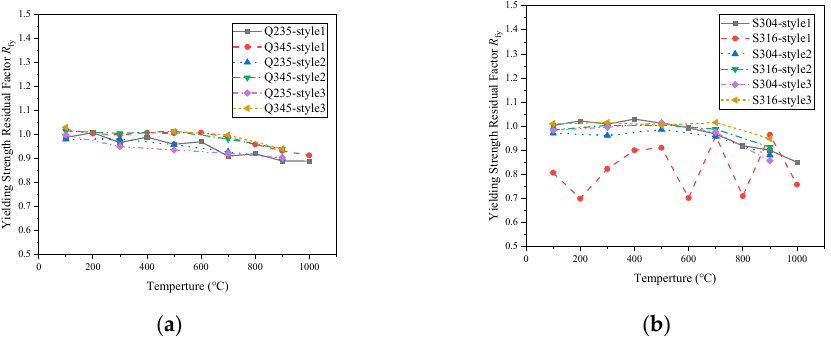
Figure 7. Yielding strength residual factor. ( a ) Q235 and Q345; ( b ) S304 and S316.